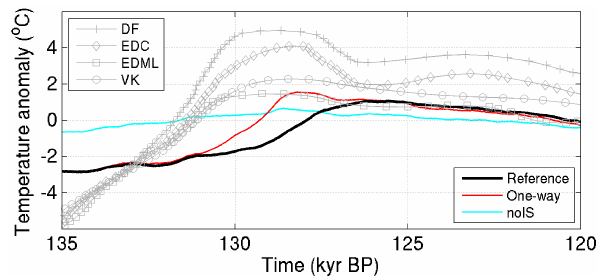
Figure 10. Comparison of modelled East Antarctic tempera- ture evolution with reconstructed temperature changes at deep ice core sites. Modelled temperature anomalies are averaged over a region 72–90 ◦ S and 0–150 ◦ E. Ice core temperature recon- structions for the sites EPICA Dronning Maud Land (EDML; 75 ◦ 00 (cid:48) S, 00 ◦ 04 (cid:48) E), Dome Fuji (DF; 77 ◦ 19 (cid:48) S, 39 ◦ 40 (cid:48) E), Vostok (VK; 78 ◦ 28 (cid:48) S, 106 ◦ 48 (cid:48) E), and EPICA Dome C (EDC; 75 ◦ 06 (cid:48) S, 123 ◦ 21 (cid:48) E) are from Masson-Delmotte et al. (2011).